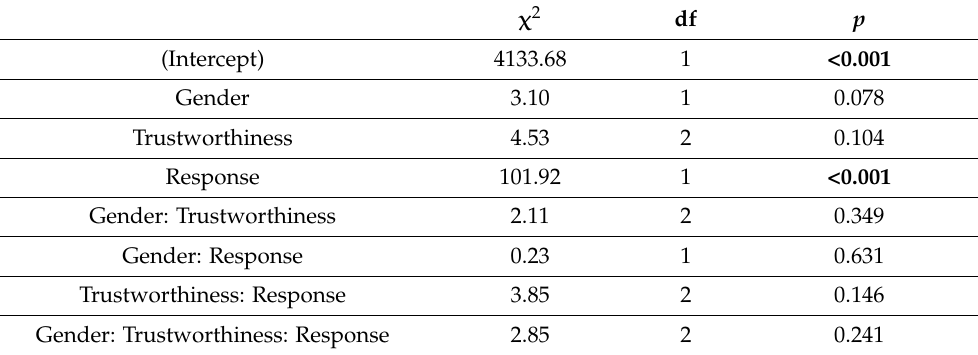
Table 4. Results of Wald χ 2 test for the glmm on response times. df = degree of freedom. Significant p values are reported in bold.